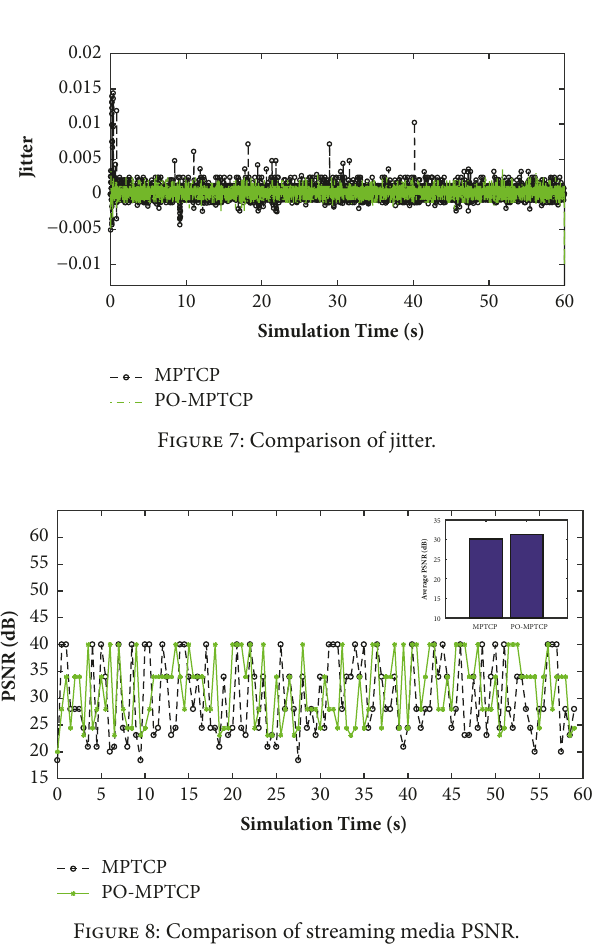
Figure 8: Comparison of streaming media